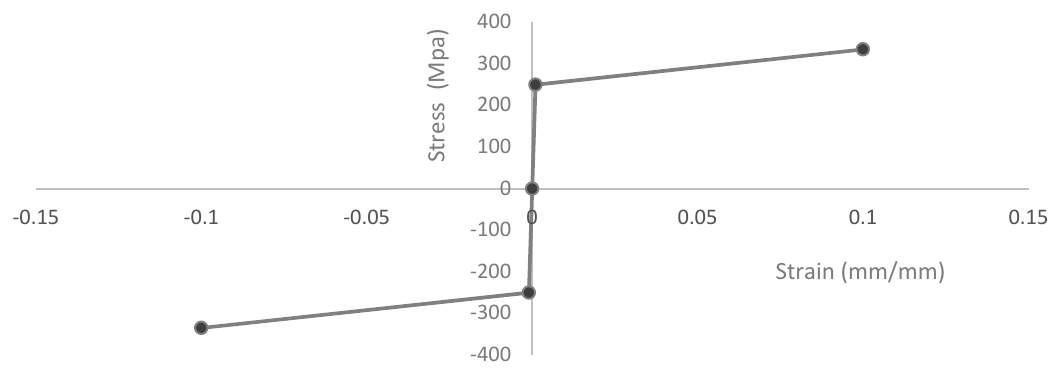
Figure 9. Stress–strain diagram of steel for the cross-section.